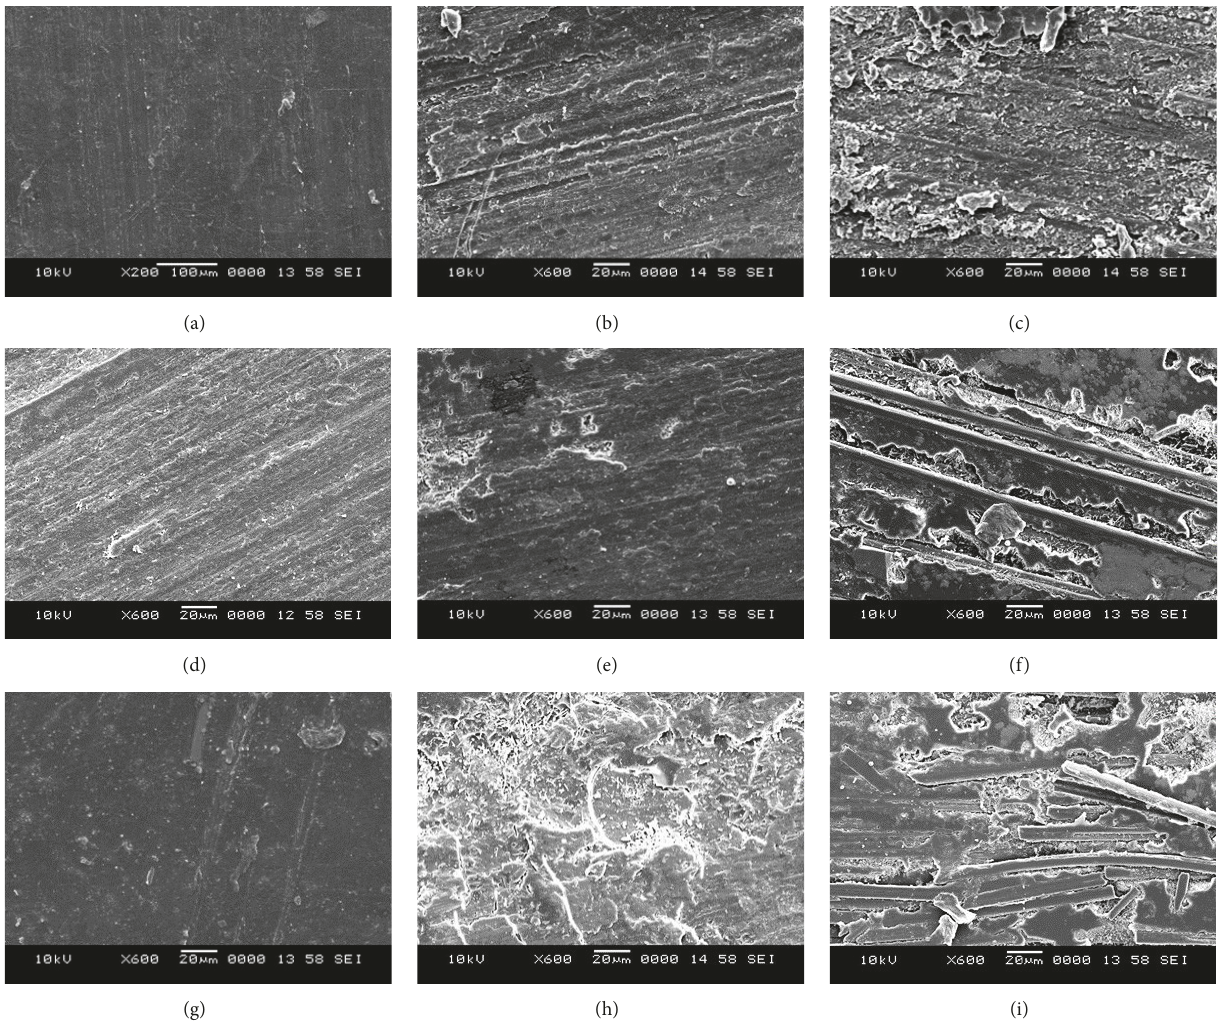
Figure 9: SEM images of worn-out surface of CCF/O-MWCNT/E composites at different loads and speeds (a) 15 N, 1.5 m. s −1 (b) 30 N, 1.5 m. s −1 (c) 45 N 1. 5 m.s −1 (d) 15 N, 2.5 m. s −1 (e) 30 N, 2.5 m. s −1 (f) 45 N, 2.5 m. s −1 (g) 15 N, 3.5 m.s −1 (h) 30 N, 3.5 m. s −1 , and (i) 45 N, 3.5 m. s −1